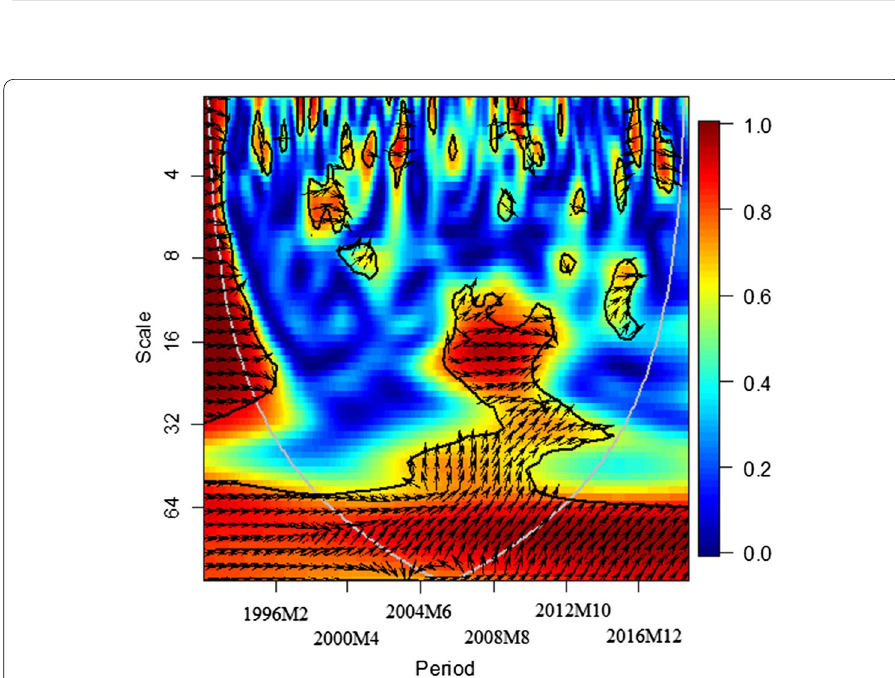
Fig. 8 Wavelet coherence between energy price index and metal price